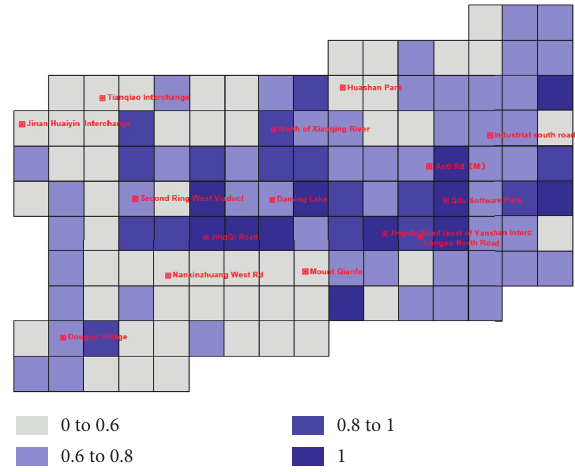
Figure 11: Distribution of coordinated development index θ ′ of traffic level to built